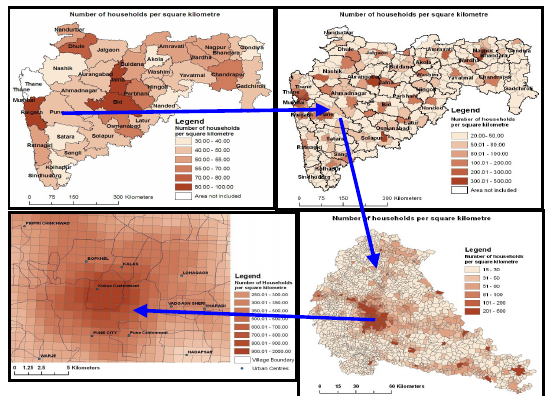
Figure 3: The effect of scale in the prediction of census metrics at (a) Districts; (b) Taluks; (c) Villages and (d) one square kilometre